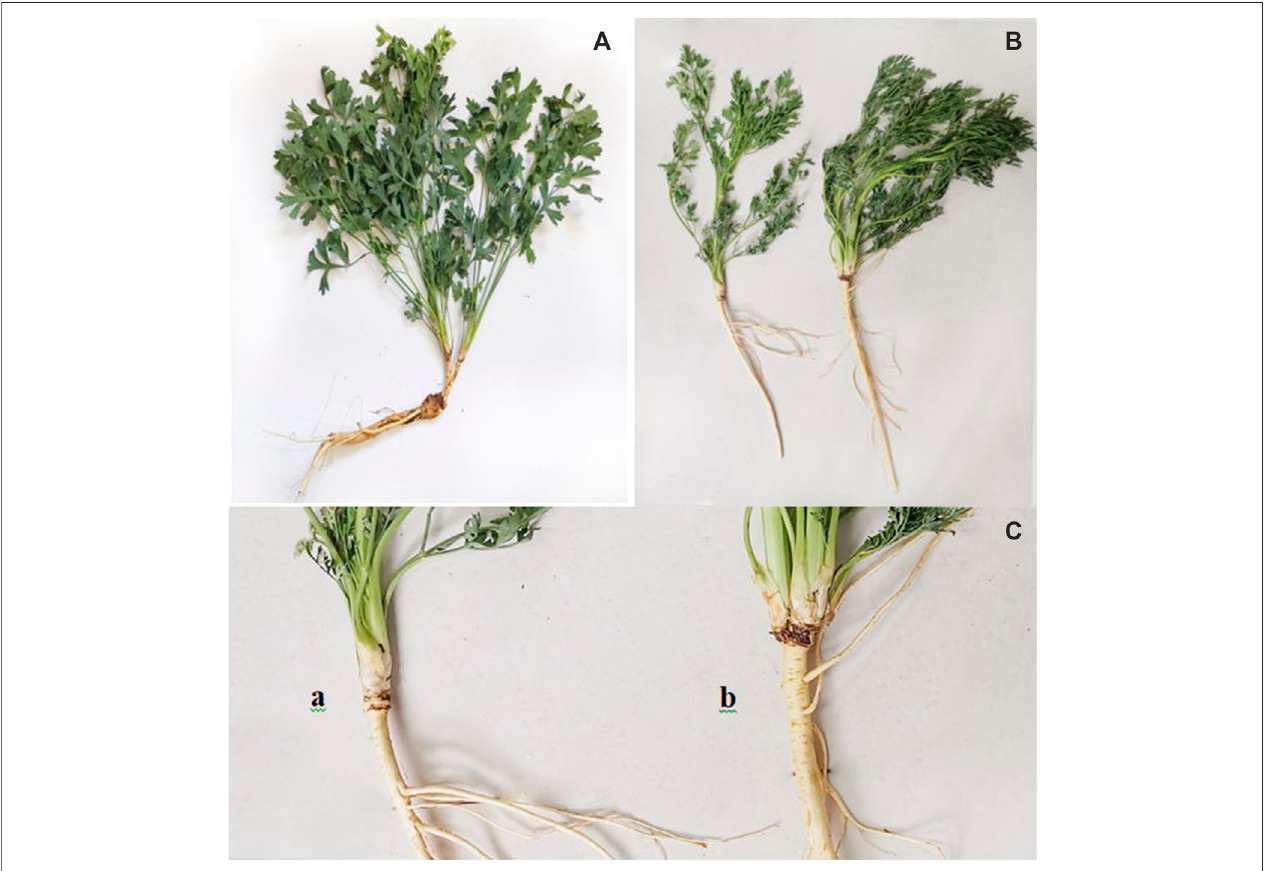
FIGURE2| ThesampleofSD.Note: (A) isdouble-headedrootSD; (B) isthewholeplantofsingle-headedrootanddouble-headedroot;In (C) ,aisasingle-headed root, and b is a double-headed root.